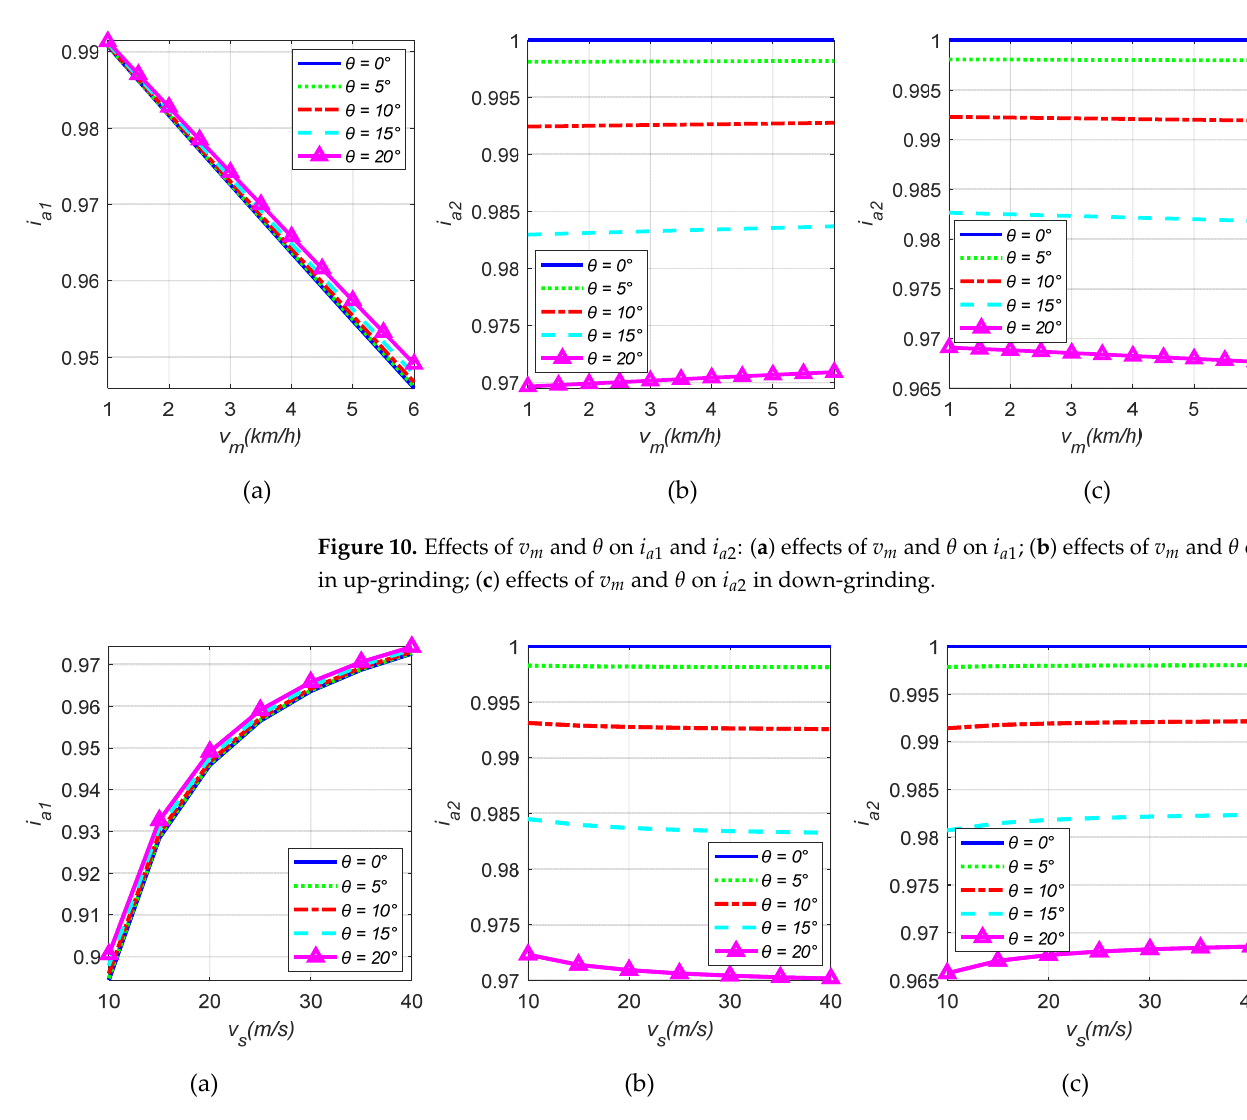
Figure 11. Effects of v s and θ on 𝑖 (cid:3028)(cid:2869) and 𝑖 (cid:3028)(cid:2870) : ( a ) effects of v s and θ on 𝑖 (cid:3028)(cid:2869) ; ( b ) effects of v s and θ on 𝑖 (cid:3028)(cid:2870) in up-grinding; ( c ) effects of v s and θ on 𝑖 (cid:3028)(cid:2870) in down-grinding.